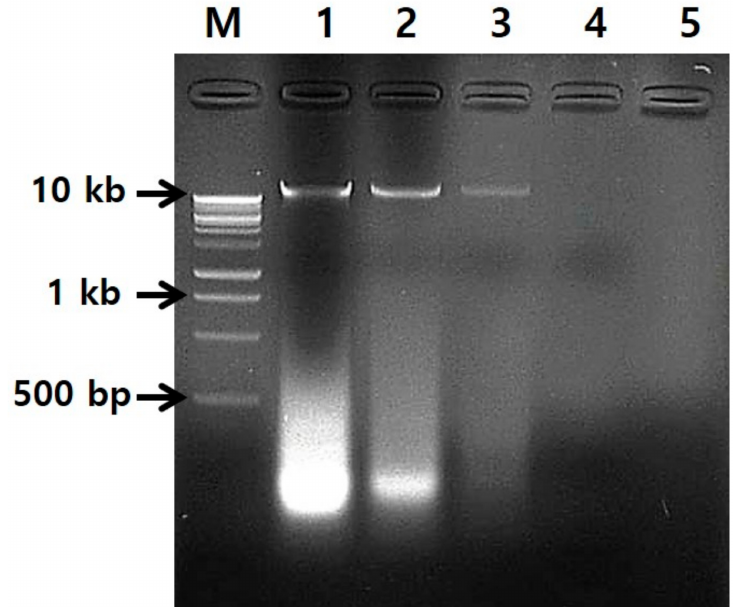
Figure 9. Electrophoretic analysis of DNA from C . pruinosa spores treated by a soft plasma jet. Lanes M and 1 represent 1 kb DNA marker and control DNA extracted from C . pruinosa spores without plasma treatment, respectively. Lanes 2, 3, 4, and 5 represent DNA extracted from 1 min, 3 min, 6 min, and 10 min, plasma-treated C . pruinosa spores,